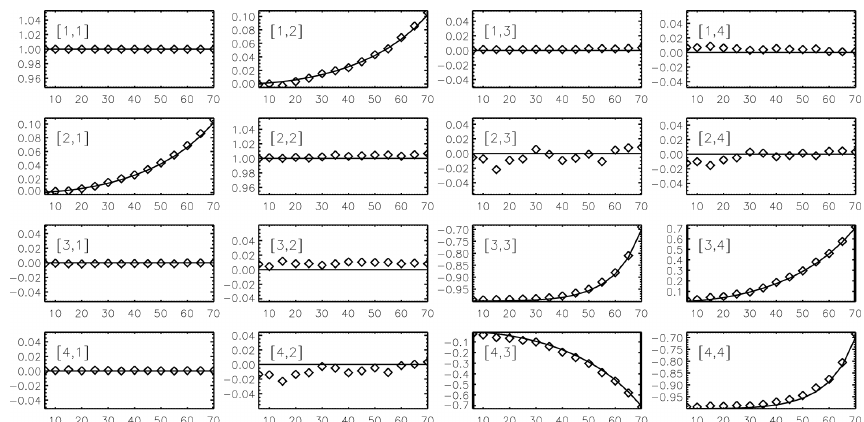
Figure 6. Normalised Mueller matrix of reflection off a real aluminium mirror with an aluminium oxide layer of measured 4.1nm on top of it at 600nm. Measurements by van Harten et al. (2009) (diamonds) and our model